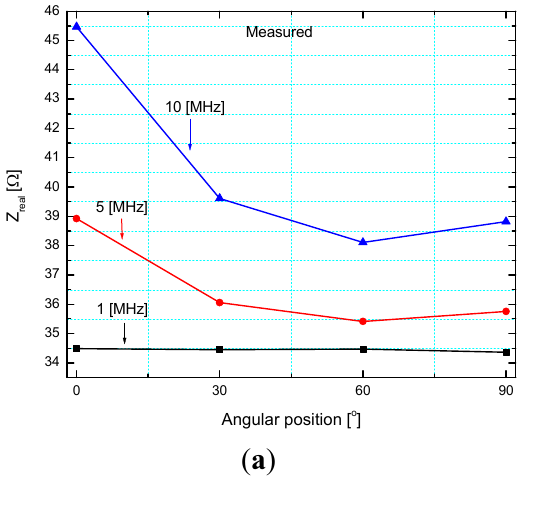
, ( b ) imaginary part– Z of the stator impedance real imag